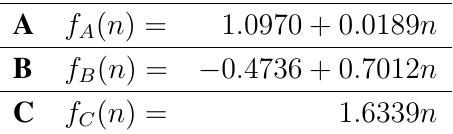
Table 1. The empirical (cases A and B ) and theoretical (case C ) linear